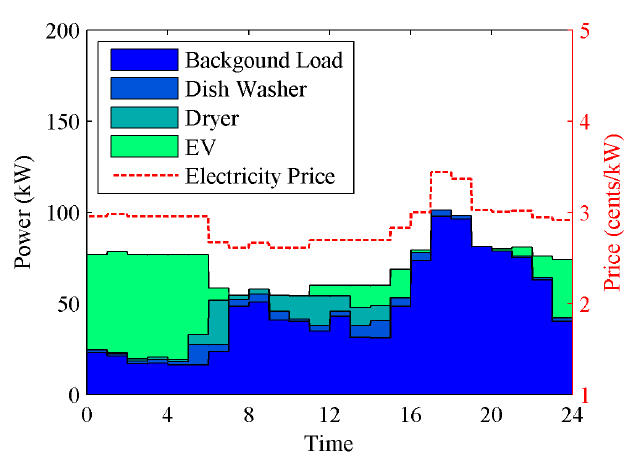
Figure 4. Aggregated load profile and electricity price in case #2.